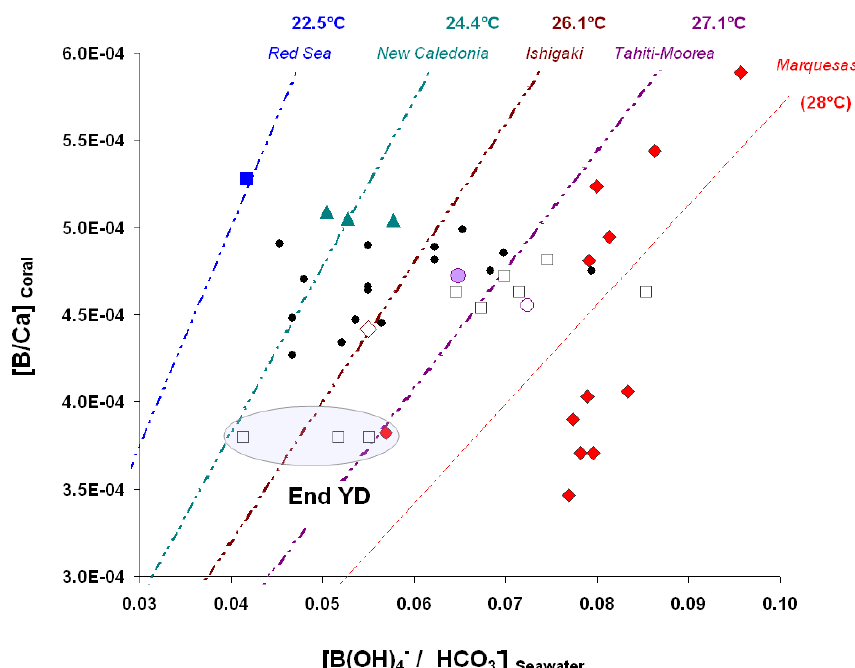
Fig. 5. B/Ca molar ratio in coral plotted against the borate/bicarbonate molar ratio in seawater. Theoretical curves for different partition coefficient K D values were calculated assuming T =28 ◦ C; S =35‰; α =0.981; and δ 11 B SW =39.9‰. Regional SSTs was used to calculate the borate/bicarbonate ratios for each of the corals. The temperature strongly influences the partition coefficient K D . Porites near Marquesas showed a K D of ∼ 0.0057. The seawater values used to calibrate the partition coefficient were [B] seawater =416µM and T CO 2